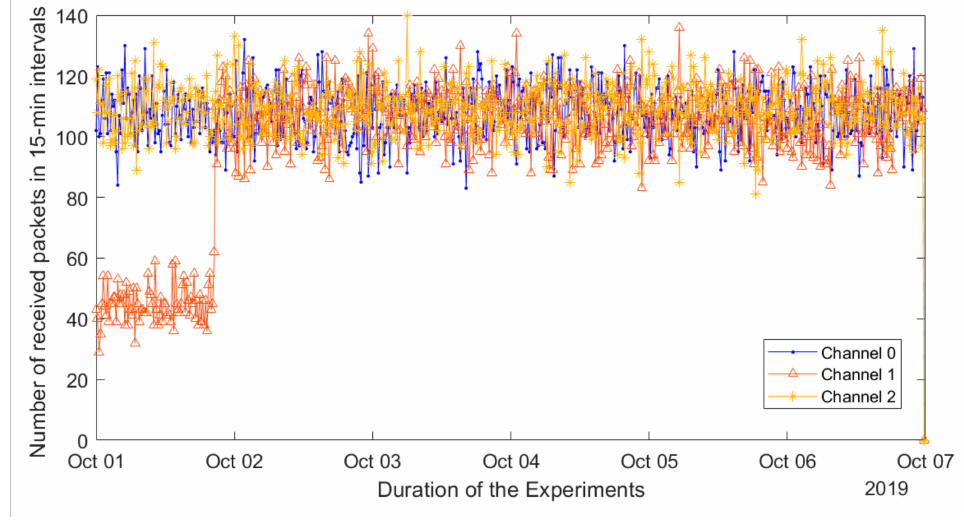
Figure 12. Analysis of the e ff ect of frequency channel on packet error rate from 1 to 7 October